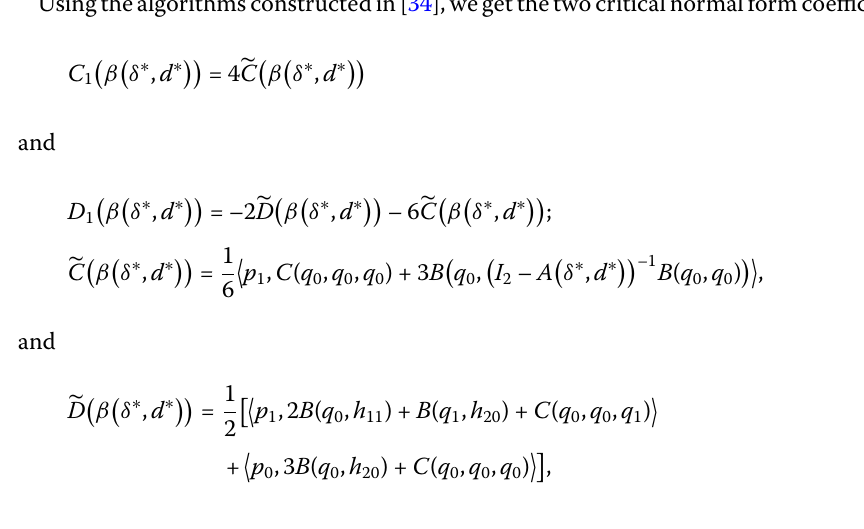
Using the algorithms constructed in [34], we get the two critical normal form coefficients (cid:7) (cid:7) (cid:8)(cid:8) (cid:7) (cid:7) (cid:8)(cid:8) (cid:15) β δ ∗ , d ∗ β δ ∗ , d ∗ C 1 C = 4